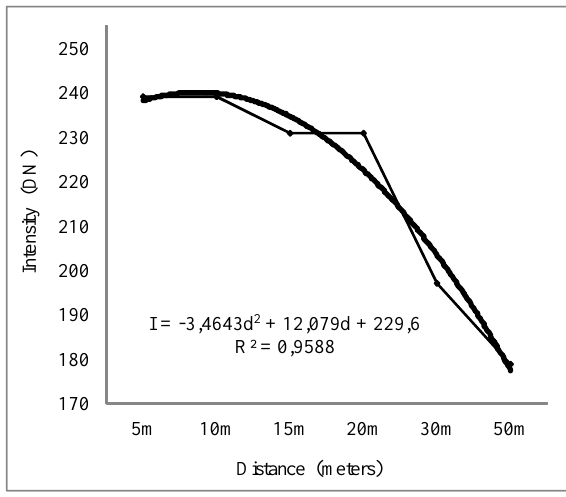
Figure 6. Mathematical model of intensity adjusted for